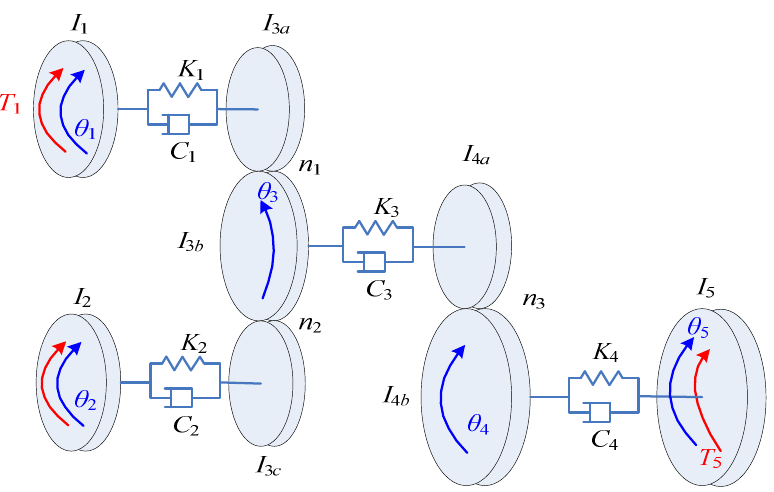
Figure 3. 5 DOF dynamic model of transmission.